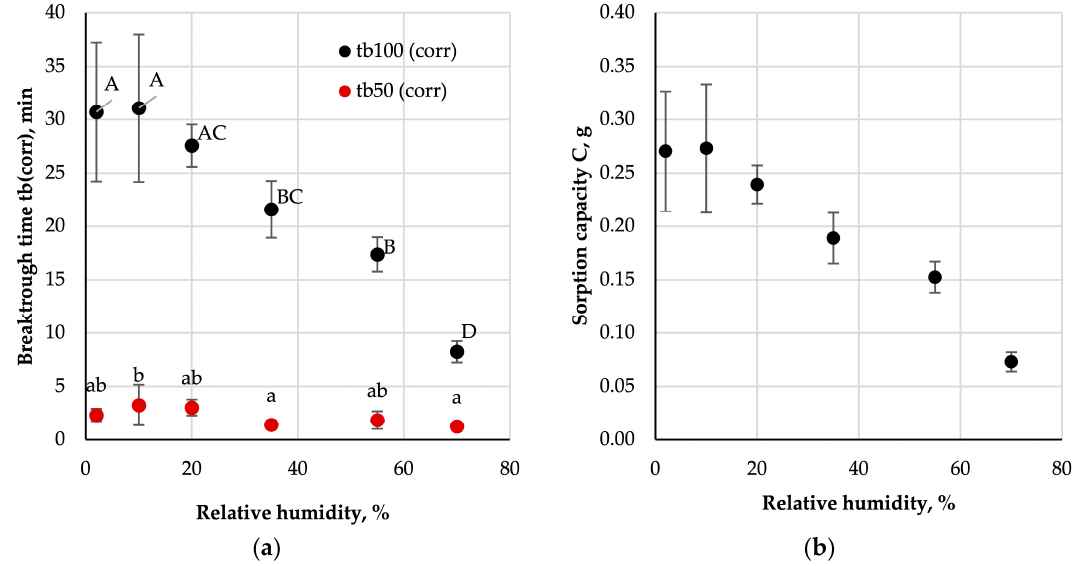
Figure 8. Influence of relative humidity on ( a ) corrected breakthrough time and ( b ) sorption capacity; A-D, a, b—statistically significant differences between mean values are marked with different letters; ANOVA, p < 0.05; Tukey’s test, p < 0.05.